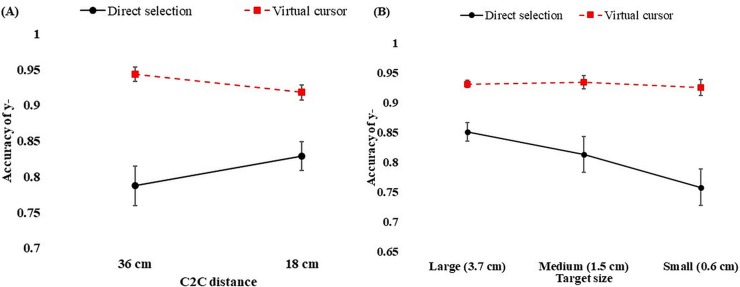
Accuracy of y-position in c2c distance (A), and interaction of target size and technique (B). The error bars represent standard error of the mean.